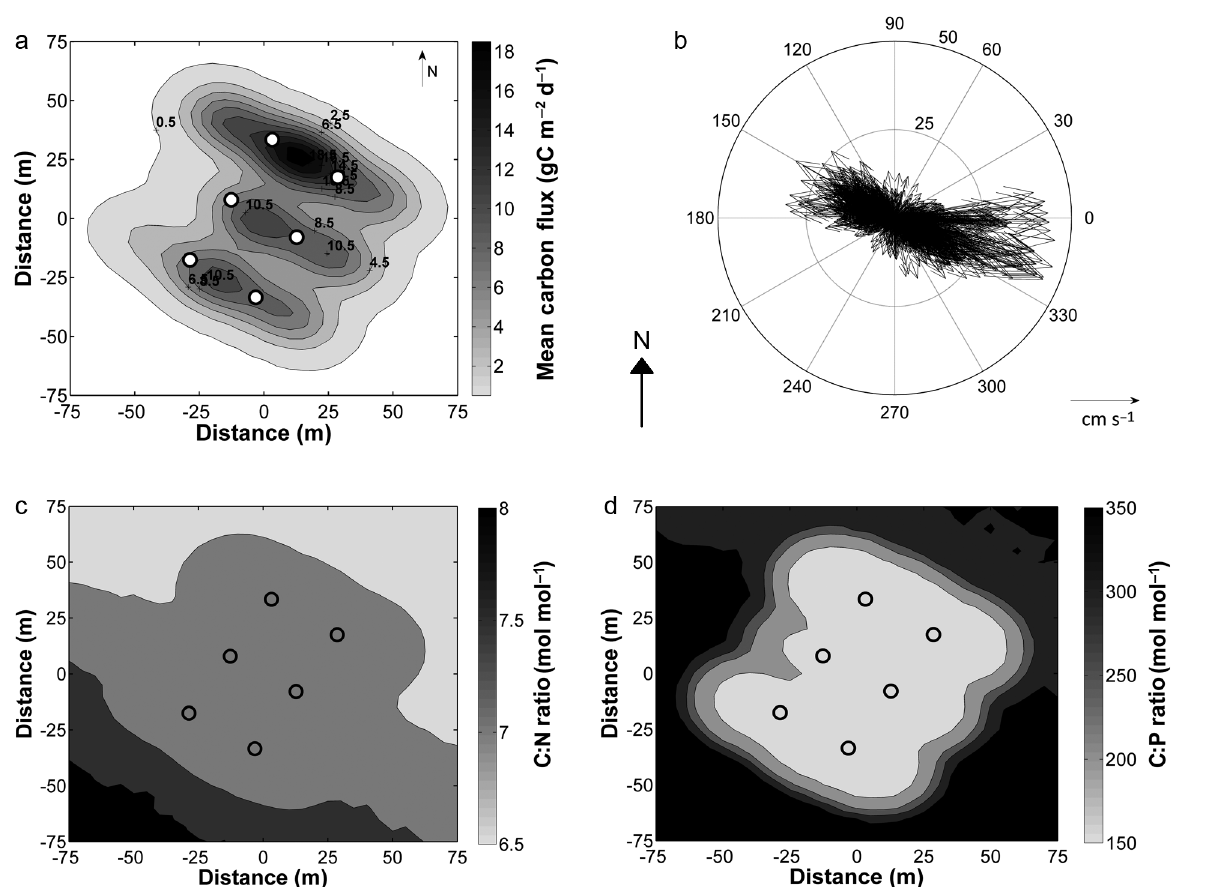
Fig. 6. Organic deposition: integrated model results under the 6-cage module in Bisceglie. (a) Mean daily organic carbon flux (g C m −2 d −1 ) for the period March 2004 to December 2006; (b) module and directions of the water currents, as measured at the farm site; and (c,d) model-predicted C:N and C:P atomic ratios in sedimented organic